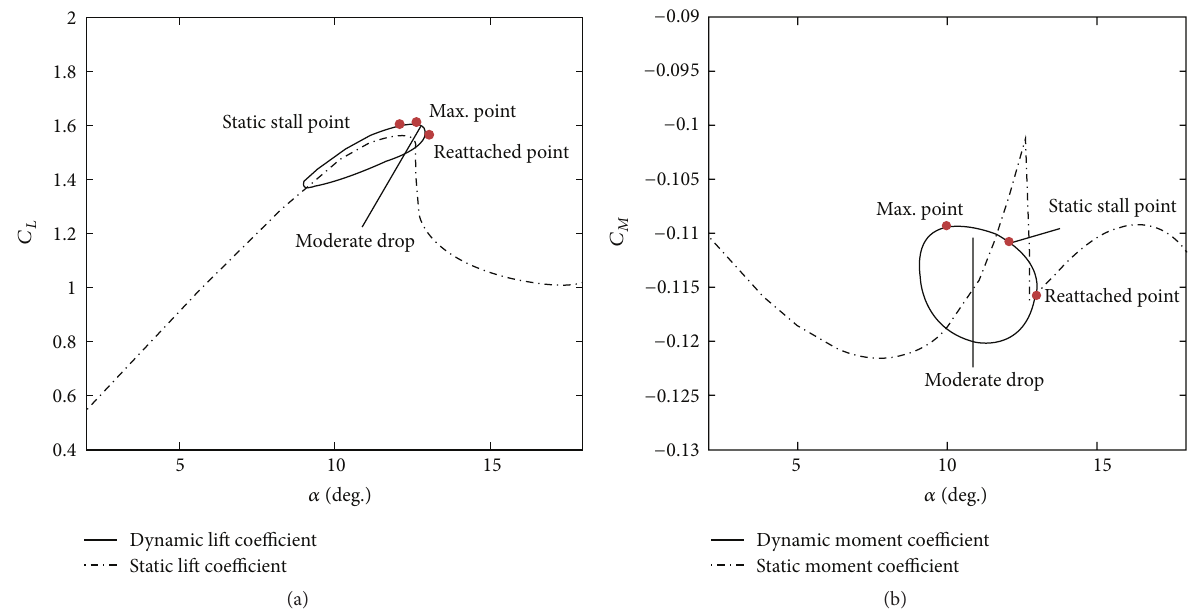
Figure 2: Moderate dynamic stall simulated curve and static experimental data. (a) Lift force coefficient and (b) moment coefficient.